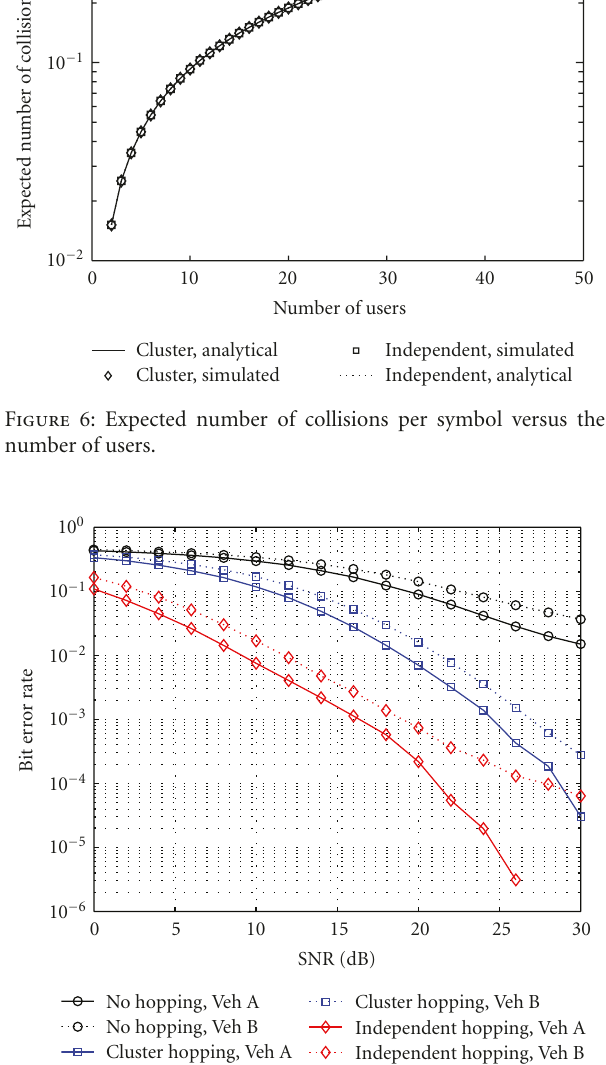
Figure 7: BER versus SNR of RNS-FH OFDMA under cluster and independent hopping with di ff erent channel conditions. N